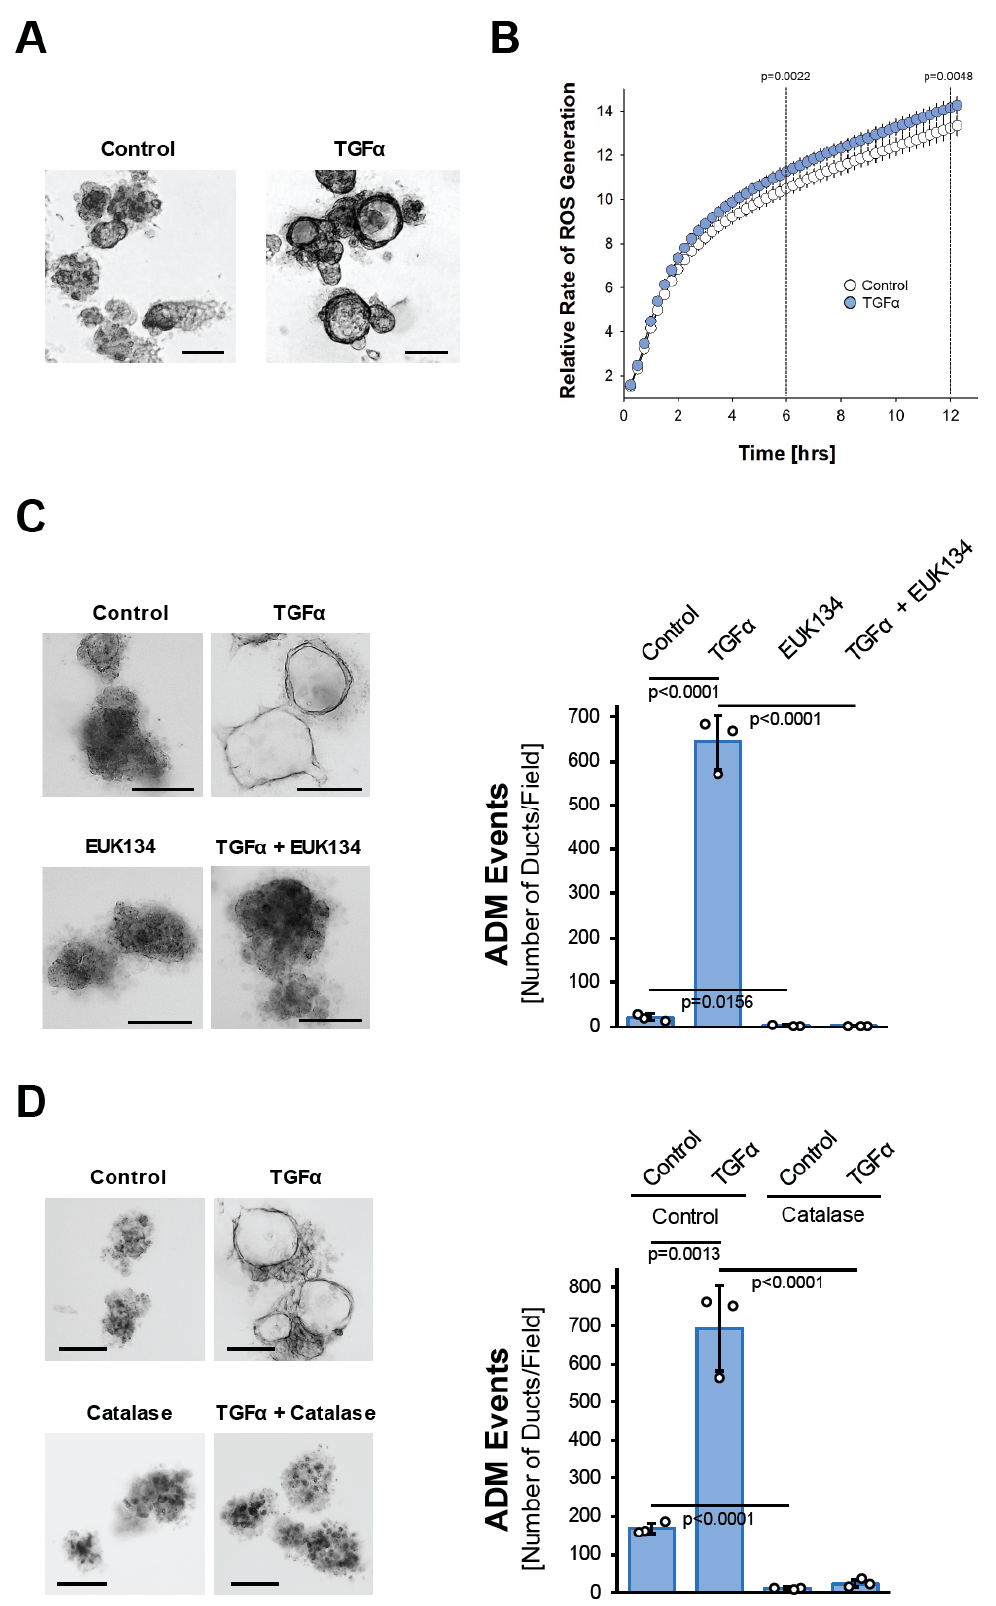
Figure 1. TGF α induces pancreatic acinar-to-ductal metaplasia through hydrogen peroxide. ( A ): Mouse pancreatic acinar cells were isolated and seeded in 3D collagen culture. ADM was induced with TGF α (50 ng/mL) and ducts formed were photographed. The bar indicates 100 µm. ( B ): Pri- mary mouse acinar cells were stimulated as indicated and labeled with H2DFFDA. Generation of intracellular ROS (fluorescent DCF) was measured over the indicated time period. ( C ): Mouse pan- creatic acinar cells were isolated and seeded in 3D collagen culture. As indicated, cells were treated with EUK134 (25 µM) and ADM was induced with TGF α (50 ng/mL). Ducts formed were photo- graphed (left side; bar = 100 µm) and quantified (right side) as indicated in the Methods section. ( D ): Mouse pancreatic acinar cells were isolated, infected with empty adenovirus (rAD-Null) or adeno- virus to express catalase (rAD-CVM-Cat) and seeded in 3D collagen culture. As indicated, ADM